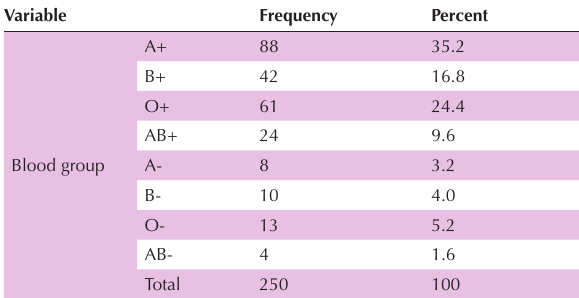
Table 1. Blood group of transplant recipients Variable